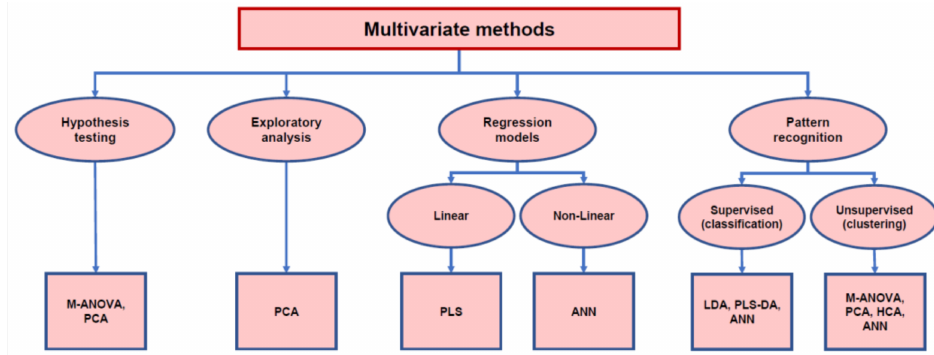
Figure 2. Schematic diagram of different objectives and multivariate statistical analysis techniques used for HS-SPME/GC-MS